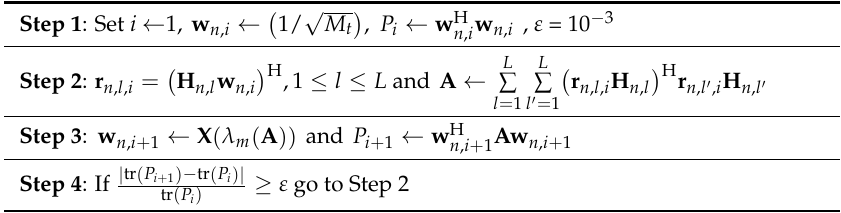
Table 1. Maximization of the signal-to-noise ratio (SNR) in diversity combining mode.